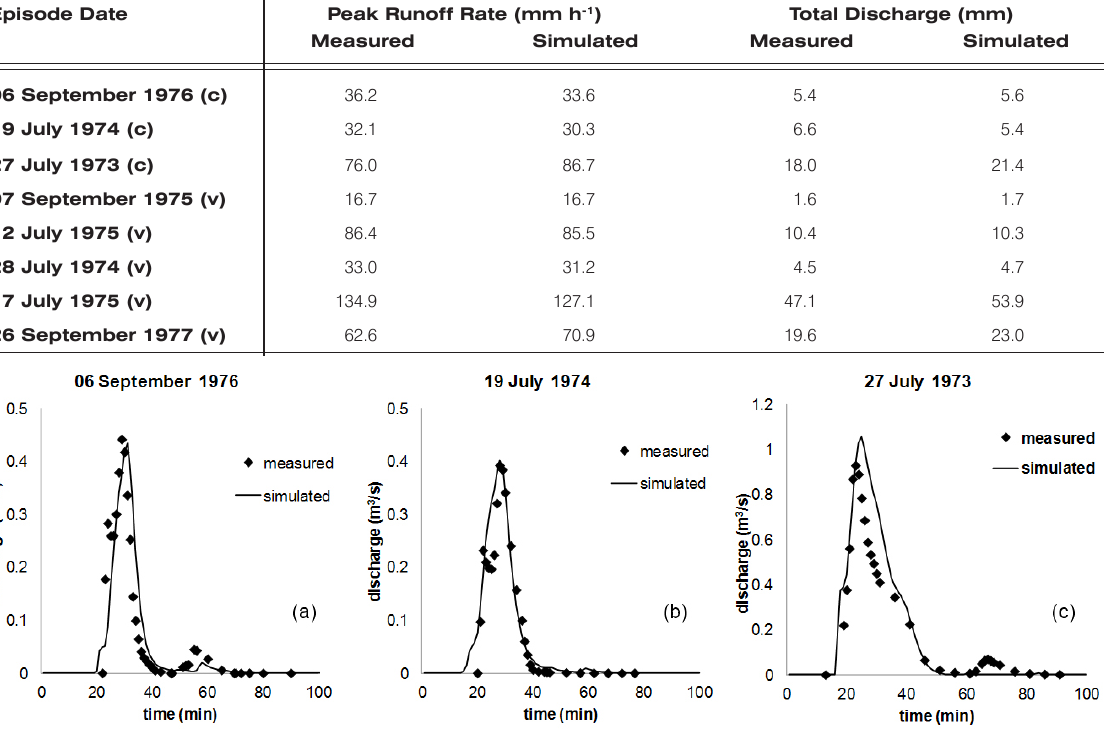
Figure 2. Measured and simulated hydrographs for the calibration base during the tuning of Manning coefficients. At the end, a final adjustment was made for K further model’s performance improvement.